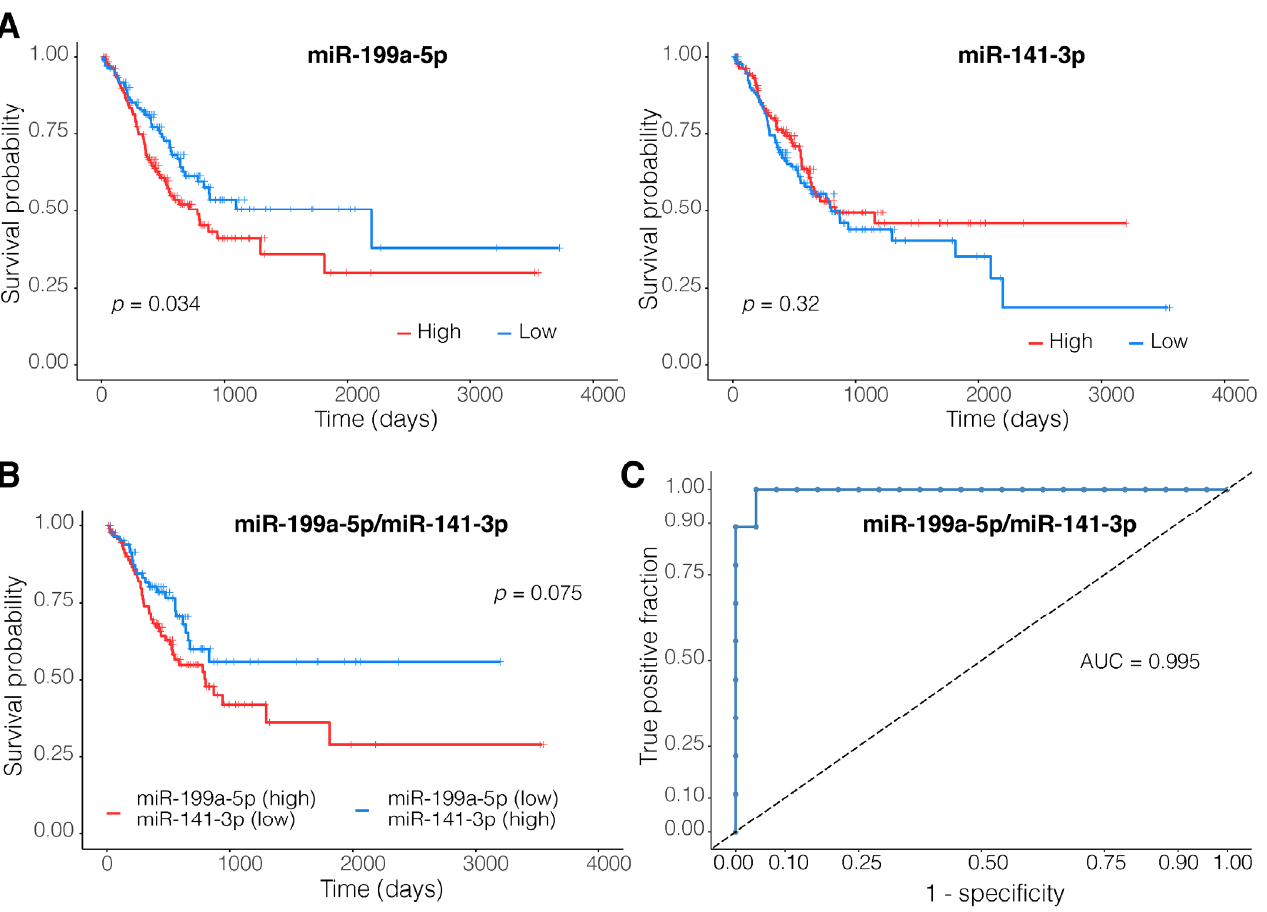
Figure 3. Top two-membered miRNA combination. Kaplan-Meier plots of ( A ) miRNAs model components and ( B ) their combination. Only the expression levels of hsa-miR-199a-5p are significantly associated with patient prognosis. ( C ) The two-membered miRNA-based diagnostic model presents an almost perfect Area Under the Receiver Operating Characteristic Curve (AUC) of 0.995 in the validation set.